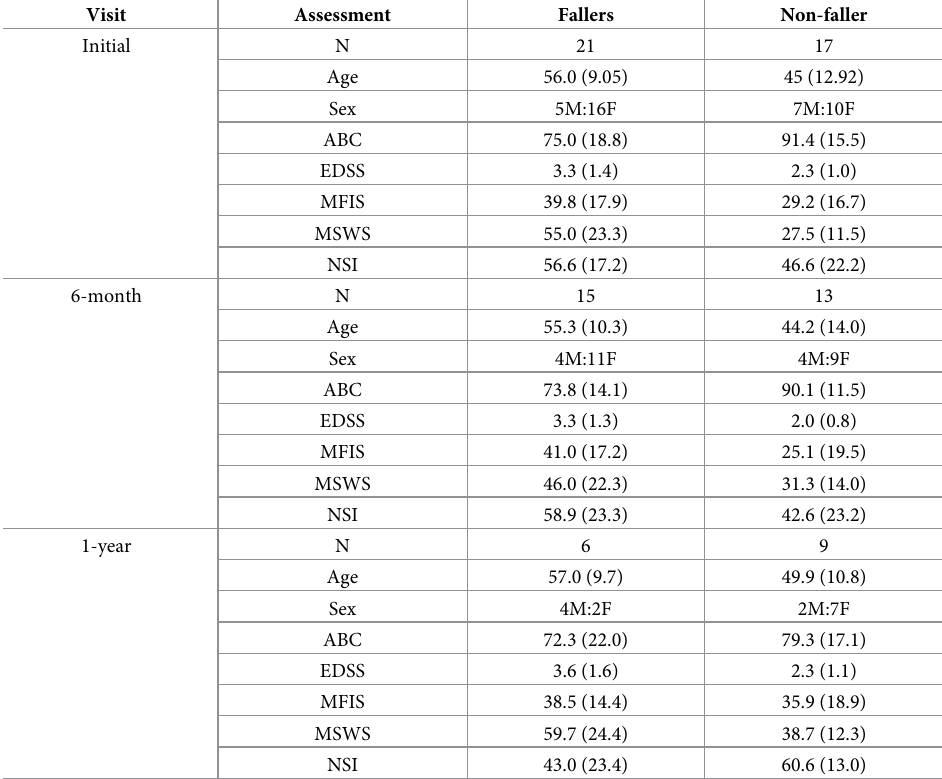
Mean (standard deviation) of survey results partitioned by fall status. ABC: Activity-Specific Balance